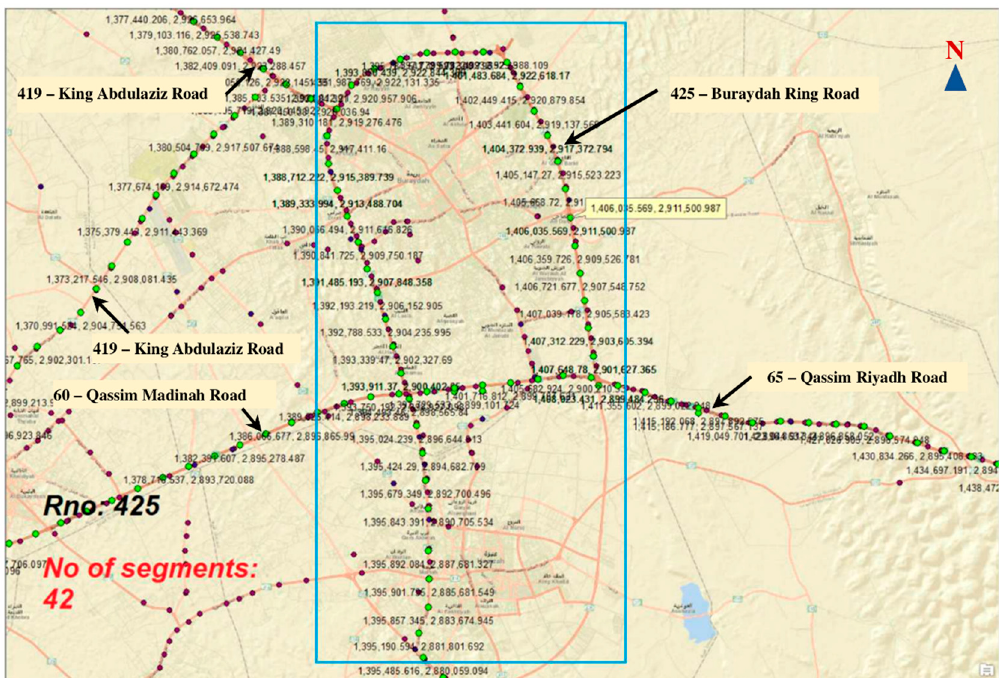
Figure 3. Number of segments on Buraydh Ring Road—Highway